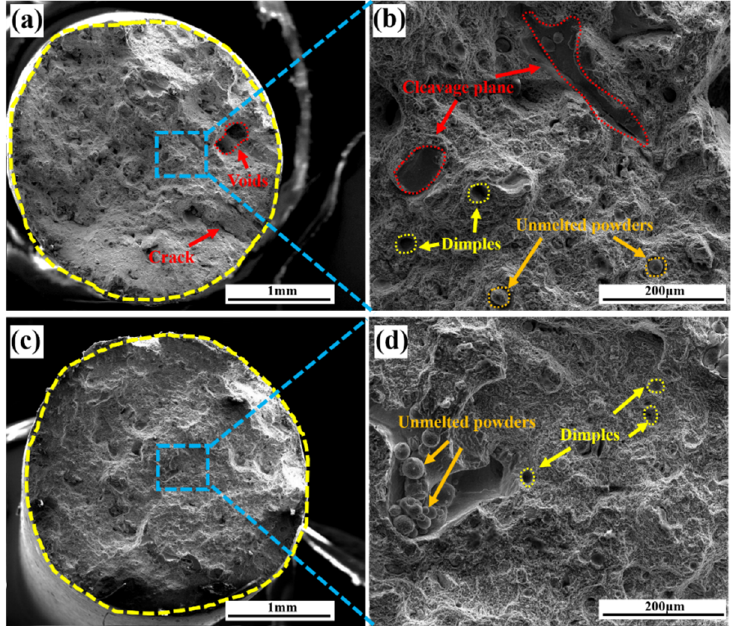
Figure 8. ( a , b ) Tensile fracture morphology of the formed parts without yttrium; ( c , d ) tensile fracture morphology of the formed parts containing yttrium.